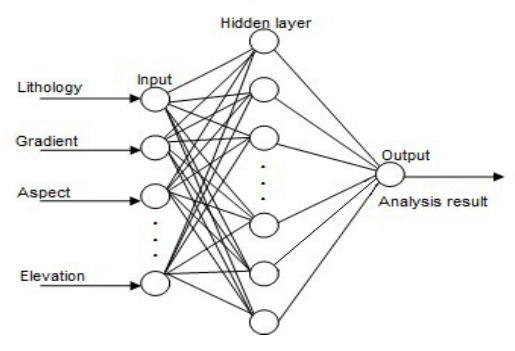
Figure 1. ANN structure chart of LS analysis